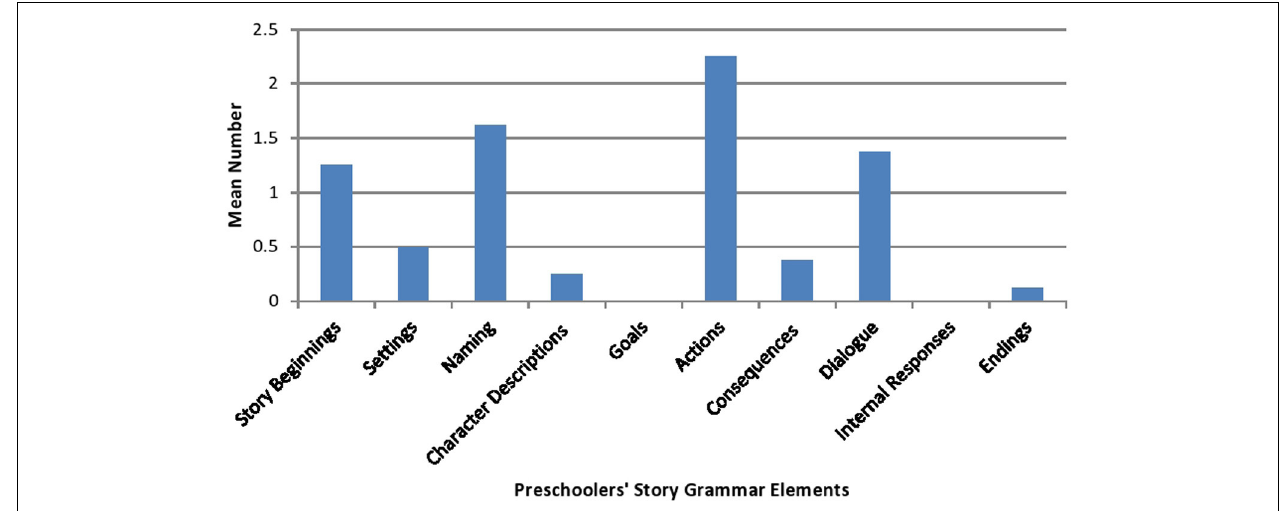
FIGURE 3 | Mean number of preschoolers’ story grammar